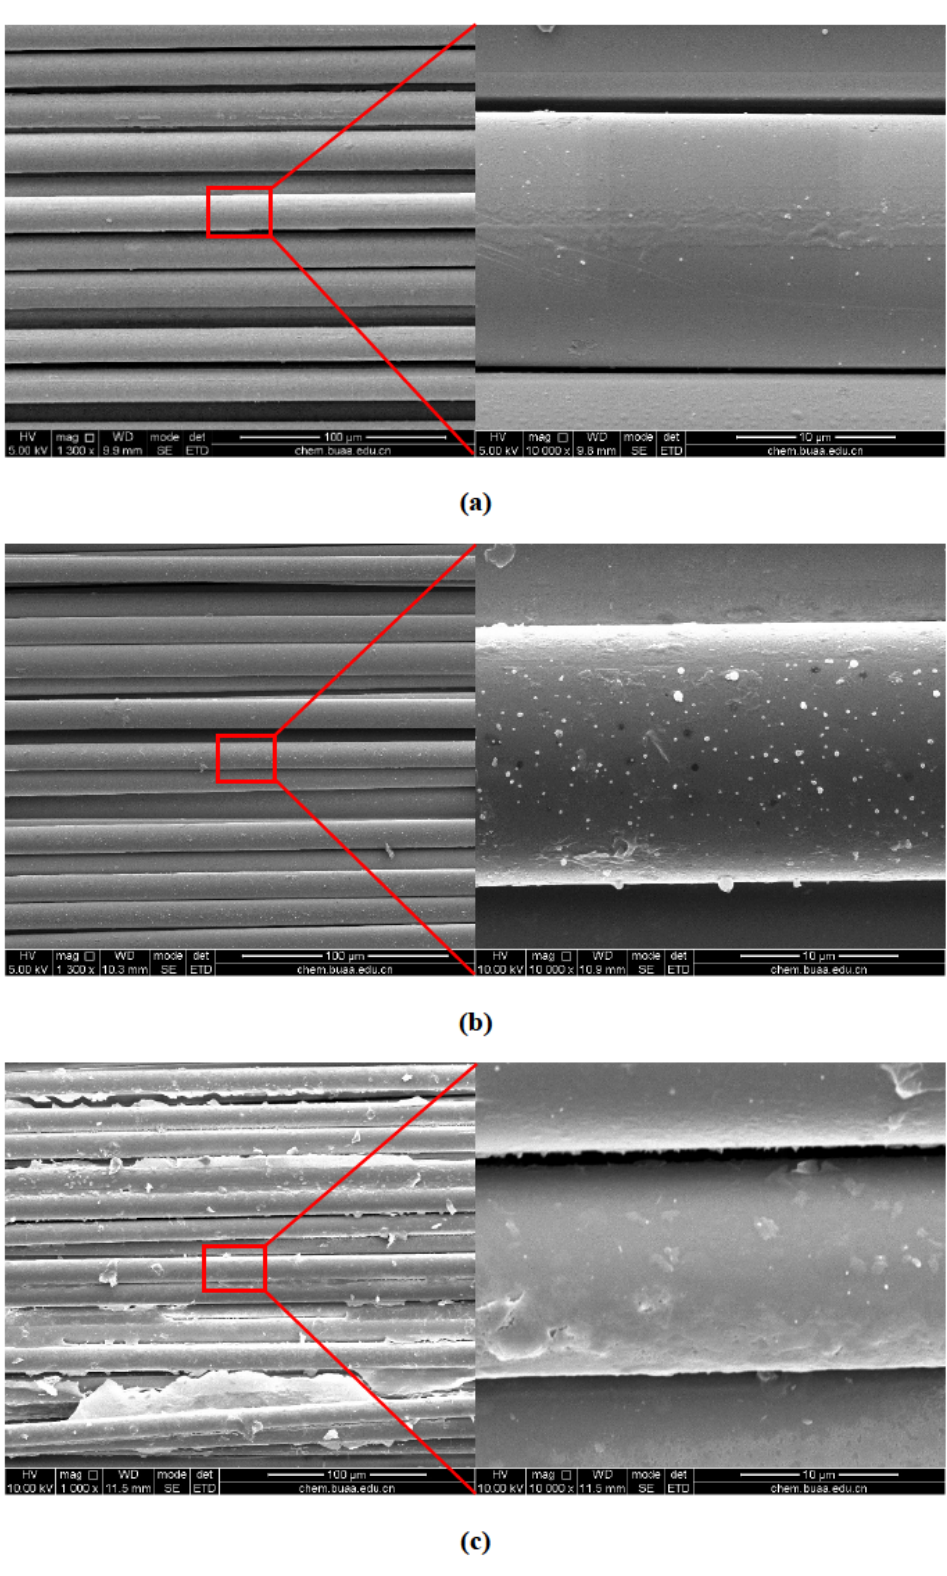
Figure 6: SEM images (left, low magnification; right, high magnification) of the glass fiber fabrics: (a) desized GF; (b) D 400 -GO-grafted GF; (c) GO-grafted